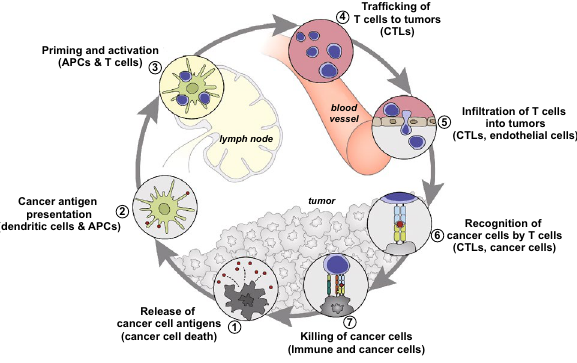
Fig. 1 Scheme illustration of the cancer-immunity cycle. Reproduced with permission from Ref. [25]. Copyright 2013